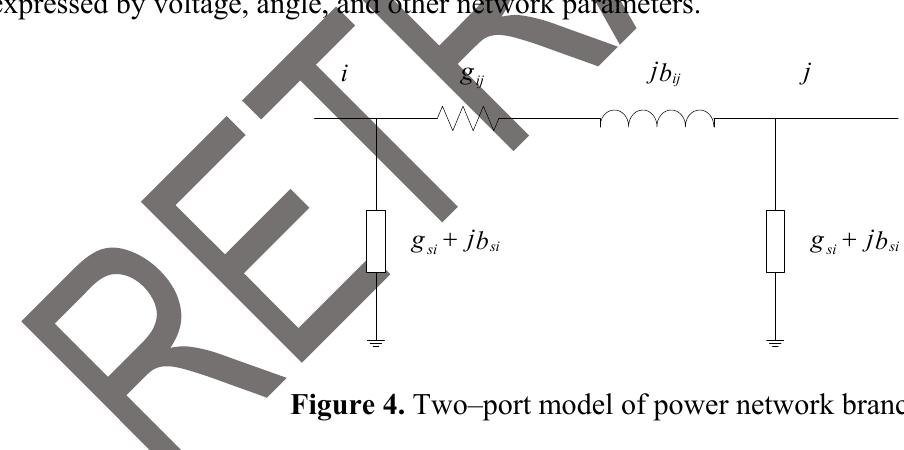
Figure 4. Two–port model of power network